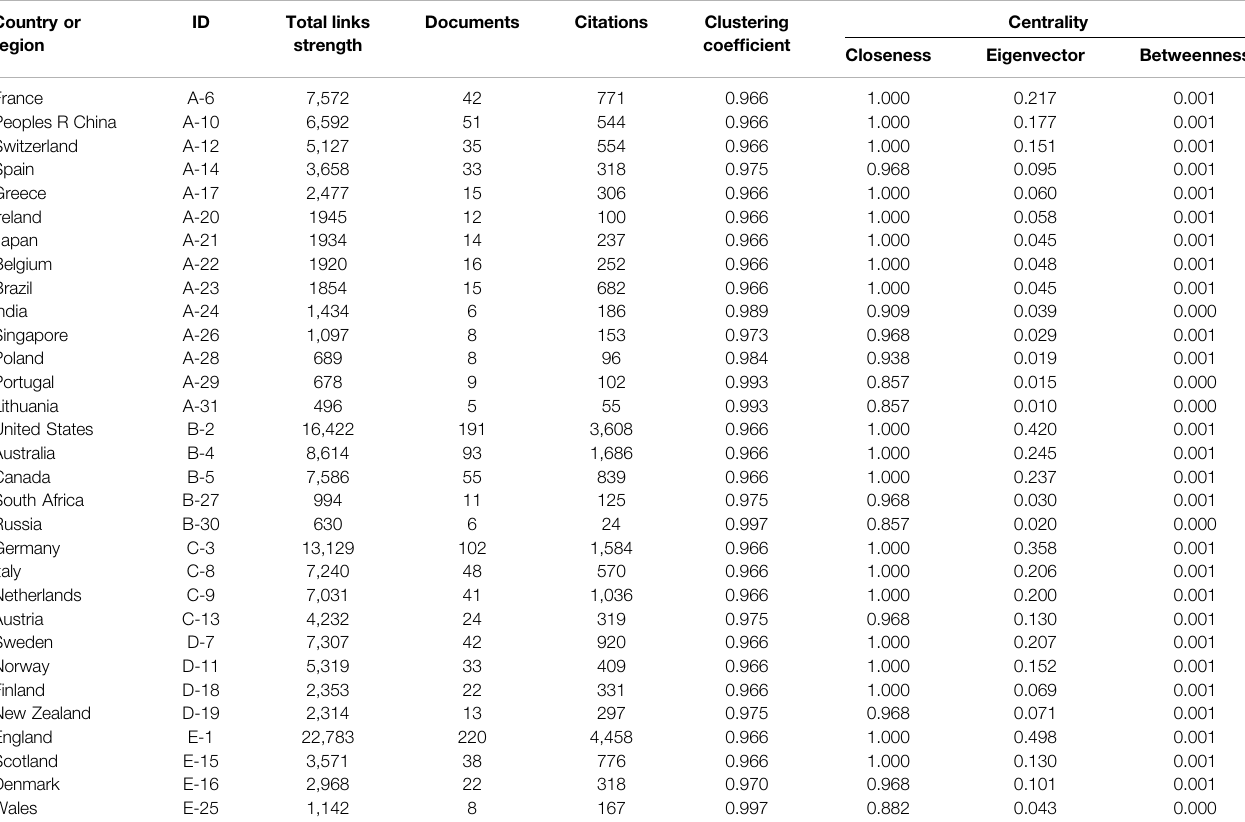
TABLE 6 | Main countries: key scientometric metrics. Country or region